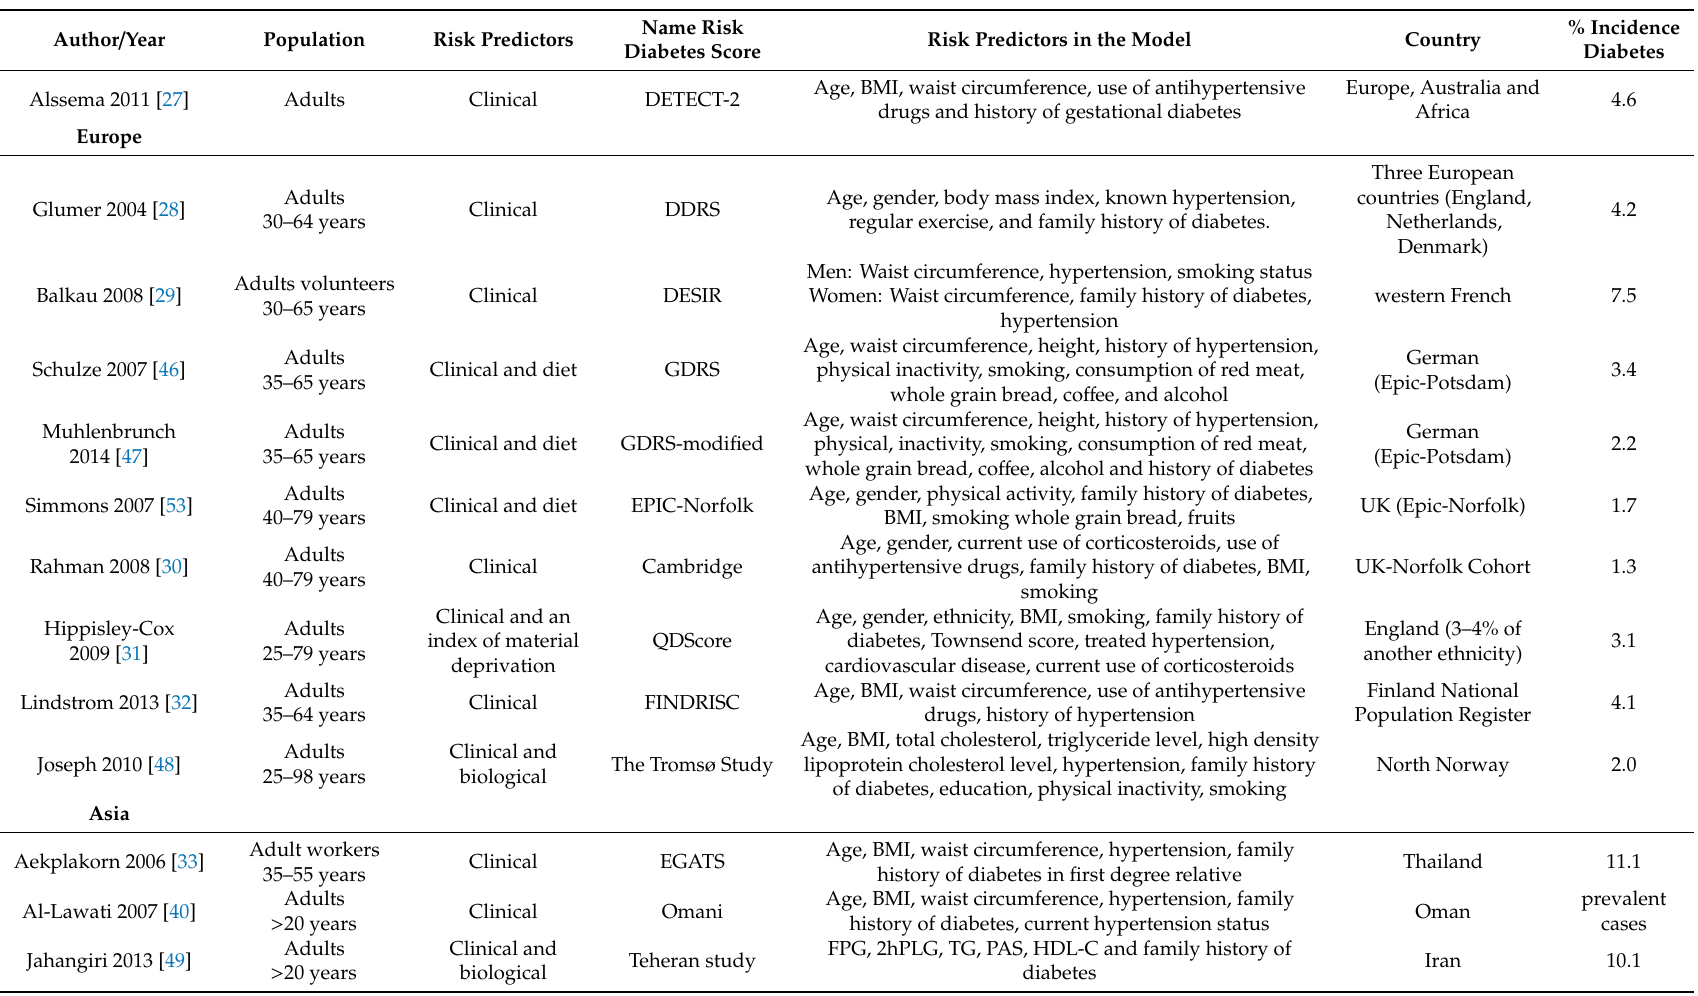
Table 1. Models included for predicting risk of incident type 2